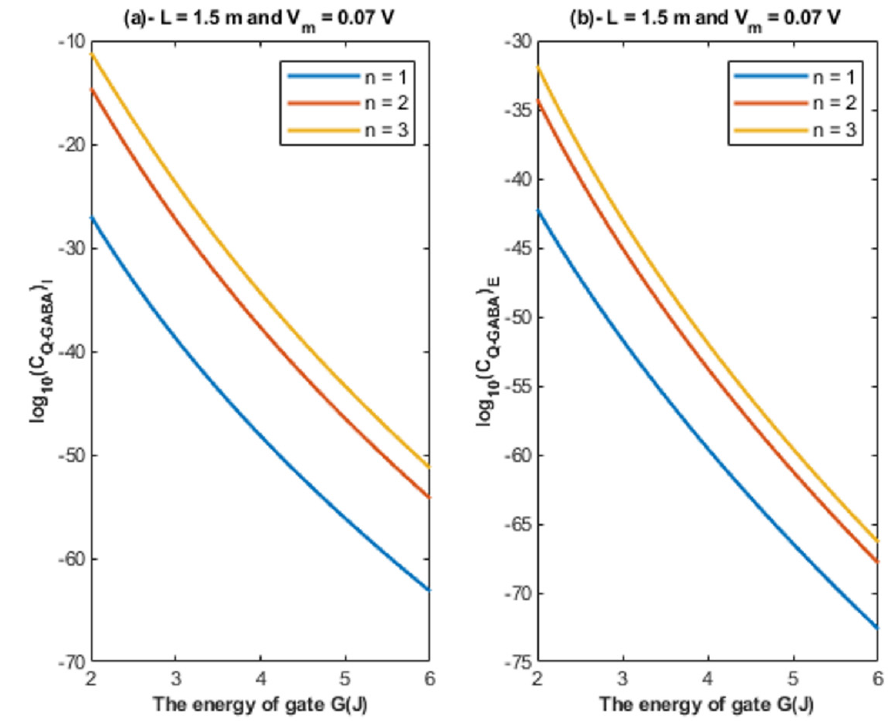
Figure 9. ( a , b ): The figure represents the relationship between the energy of the gate G and the common logarithm of the quantum unitary conductance of the intracellular chloride ions and the quantum unitary conductance of the extracellular chloride ions log ( ) C − 10 Q GABA I log ( ) C − , respectively. The relationships are investigated at different values of gate 10 Q GABA E location and according to the setting values above each graph.